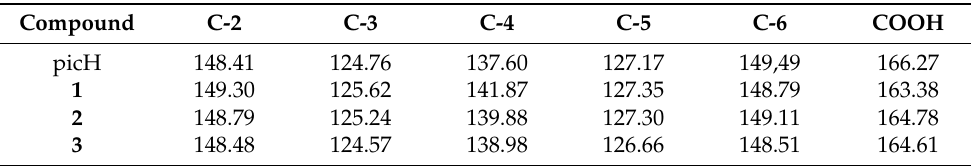
Table 1. 13 C NMR chemical shifts ( δ ) a in ppm of picH, {[HgCl(pic)]} n ( 1 ), [HgCl(pic)(picH)] ( 2 ), and [HgBr(pic)(picH)] ( 3 ).